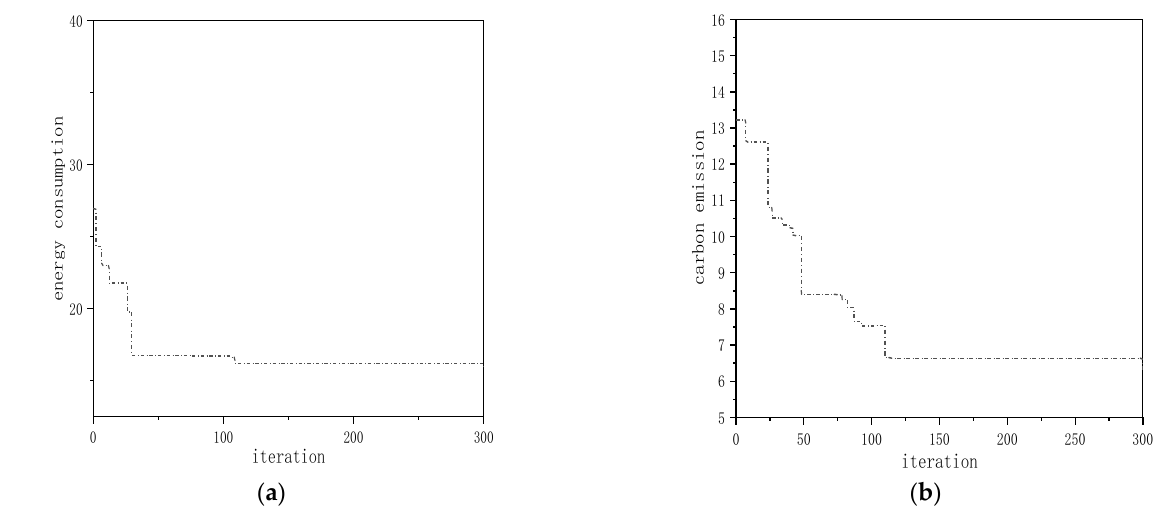
Figure 7. Iterative convergence graph of blank 1. ( a ) Energy consumption ( b ) Carbon emission.